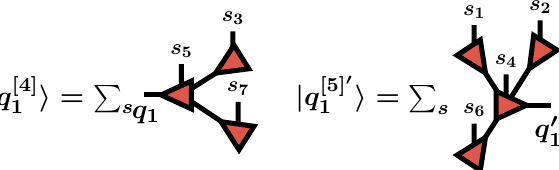
Figure 6: Definition of the states used in the projection operator onto the link q defined in the second line of Eq. 15 for link q